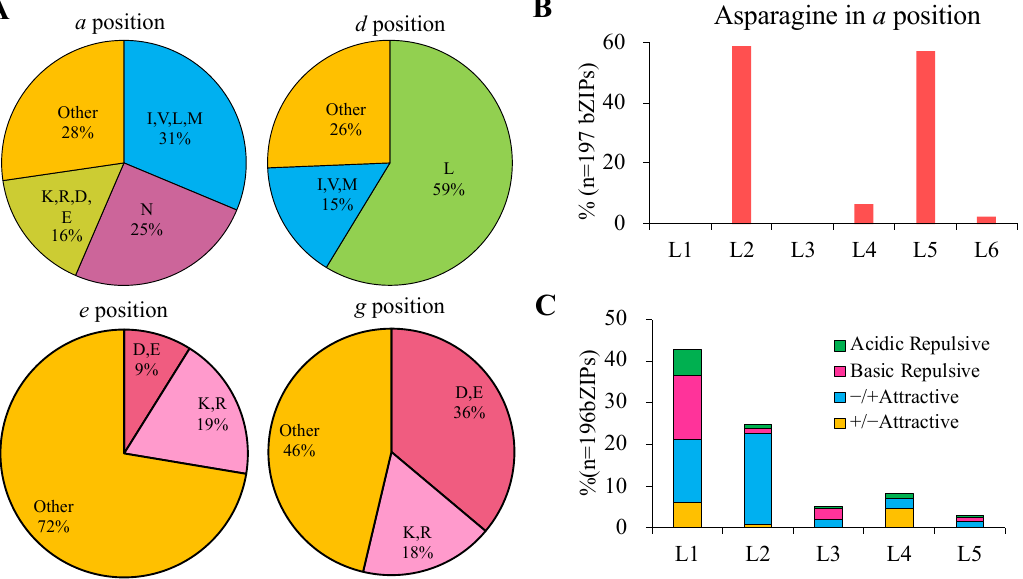
Figure 6. Prediction of the dimerization properties of 197 GhbZIP proteins. ( A ) Frequency diagram of different amino acids at a , d , e, and g positions in heptads of GhbZIP protein. ( B ) The frequency of Asn residues present in GhbZIP proteins at the a position in each heptad. ( C ) The frequency of attractive or repulsive g ↔ e ′ pairs in each heptad in GhbZIP proteins.